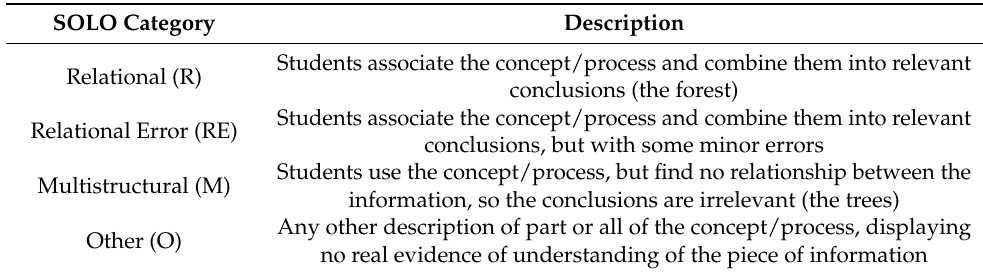
Table 8. SOLO categories for relational reasoning